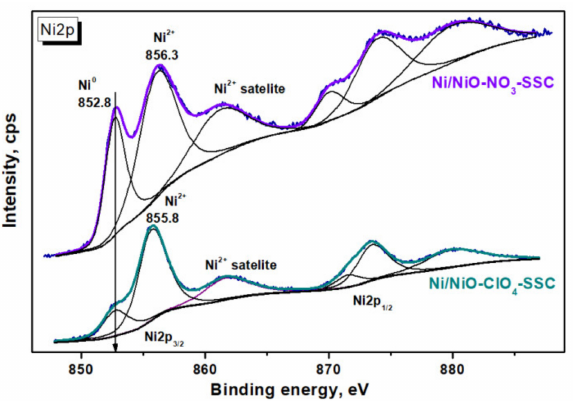
Figure 11. Deconvoluted XPS spectra of Ni/NiO-NO 3 -SSC and Ni/NiO-ClO 4 -SSC samples after activation at 450 ◦ C in the reaction medium (H 2 :CO 2 :Ar =